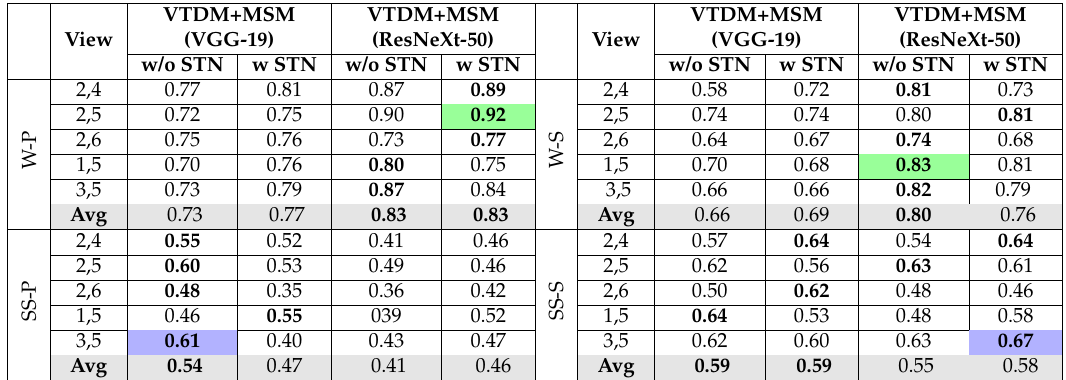
Table 6. Cross-view results for all actions with two-view training. The bold numbers show the best result for each combination of views of each action type; Green highlights: best results for W-P and W-S actions amongst all view combinations, Purple highlights: best results for SS-P and SS-S actions amongst all view combinations.